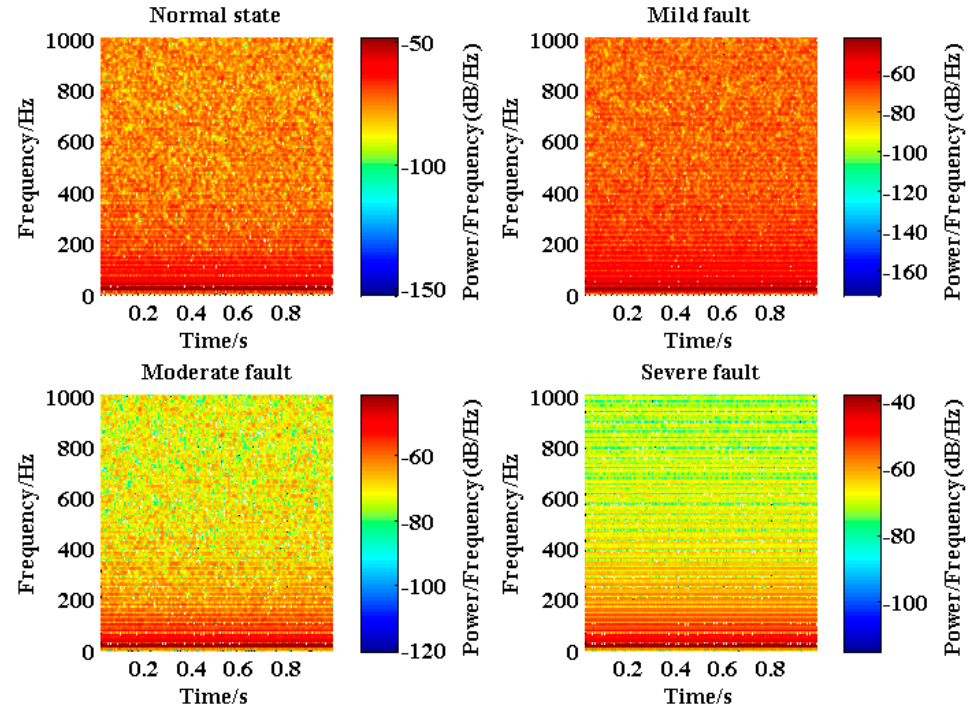
Figure 6. Power spectral density of transformer vibration signal.